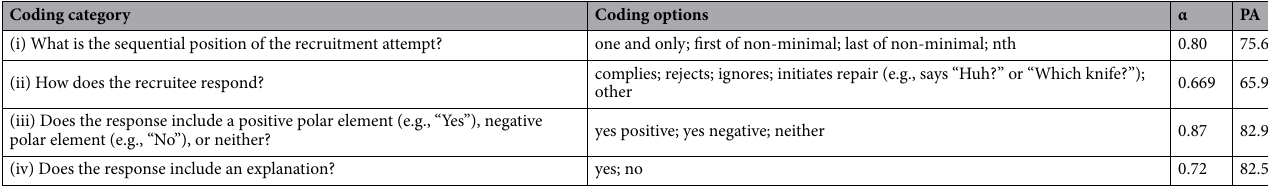
Table 5. Inter-coder reliability. Krippendorff’s α and simple percent agreement (PA) achieved by each coding category focused on in this study (before any re-coding was